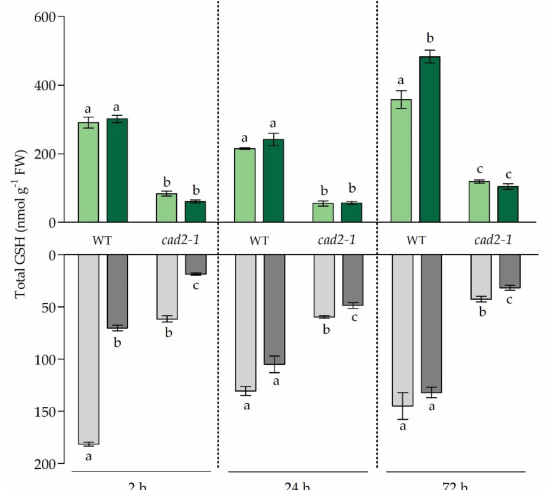
Figure 2. Total glutathione (GSH) concentrations (nmol g − 1 fresh weight) in leaves (green bars)